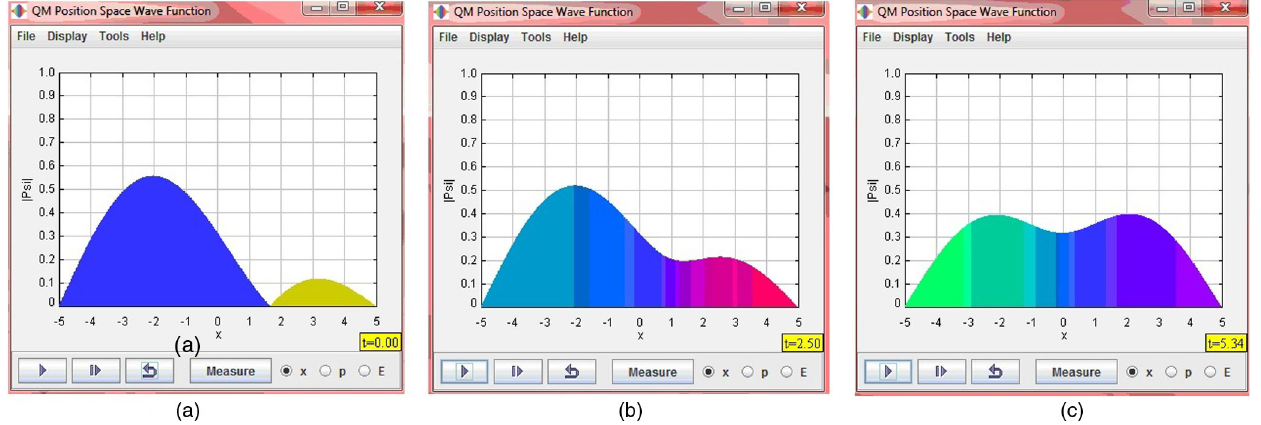
FIG. 5 (color online). Time evolution on a superposition state with two energy eigenstate components. (a) The absolute value of the initial state wave function ( t ¼ 0 ). (b),(c) The absolute values of the wave function at different times [(b) t ¼ 2 : 50 units, (c) t ¼ 5 : 34 units]. The phases of the wave function are represented by different